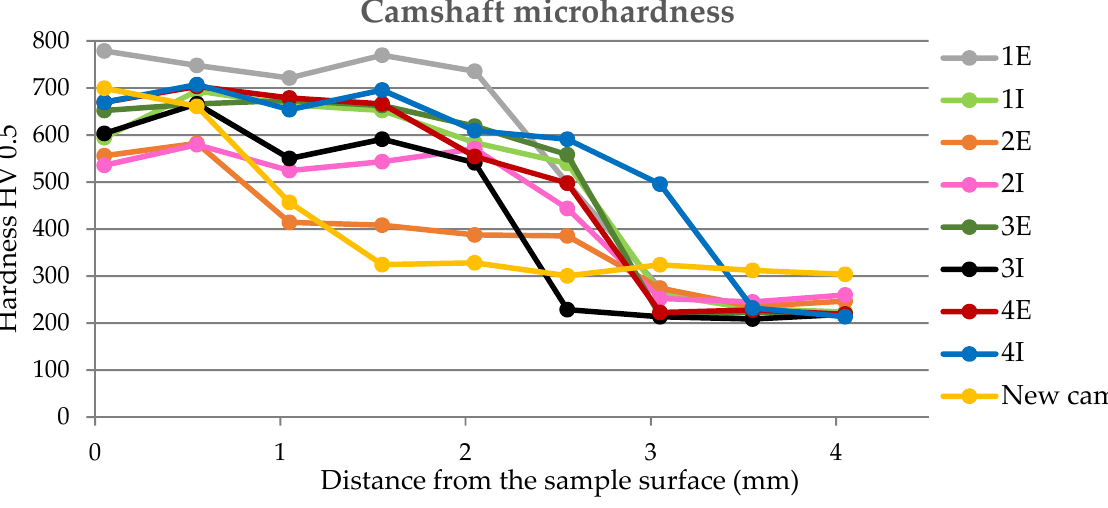
Figure 12. Camshaft microhardness curves (HV 0.5).